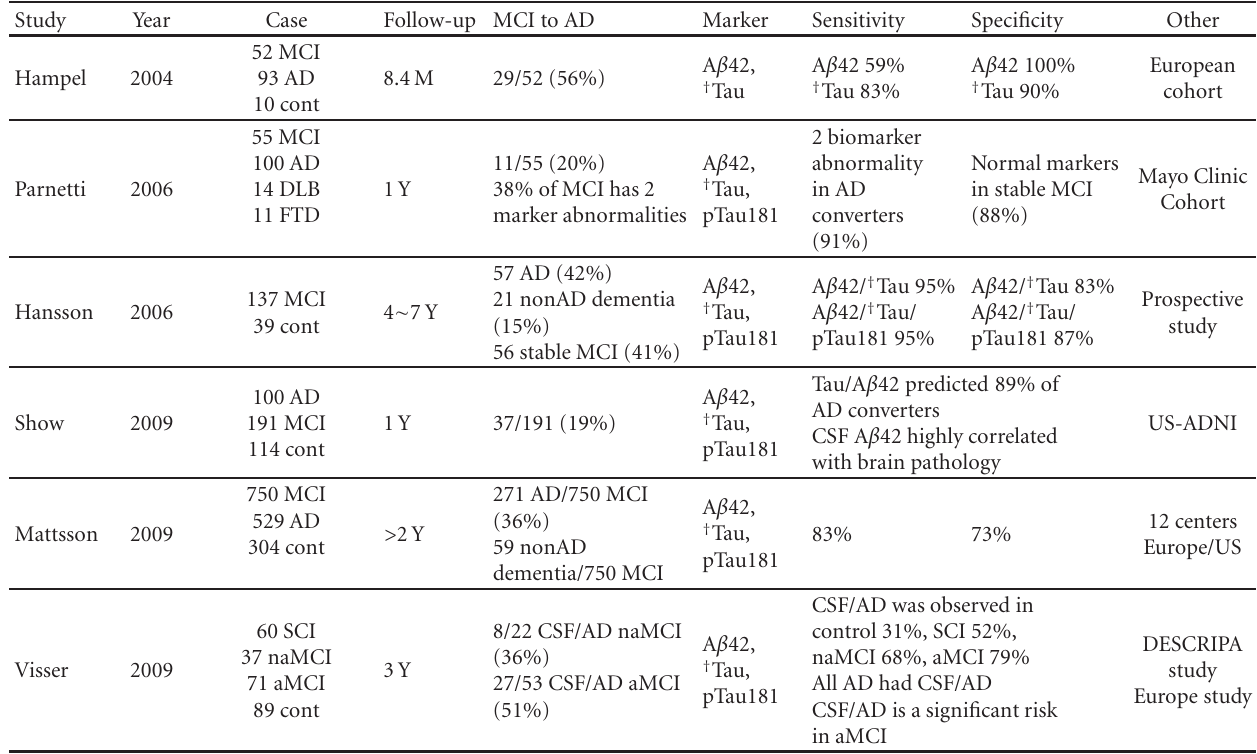
Table 2: Major studies of CSF biomarker to predict progression from MCI to AD published between 2004 and 2010. Study Year Case Follow-up MCI to AD Marker Sensitivity Specificity Other